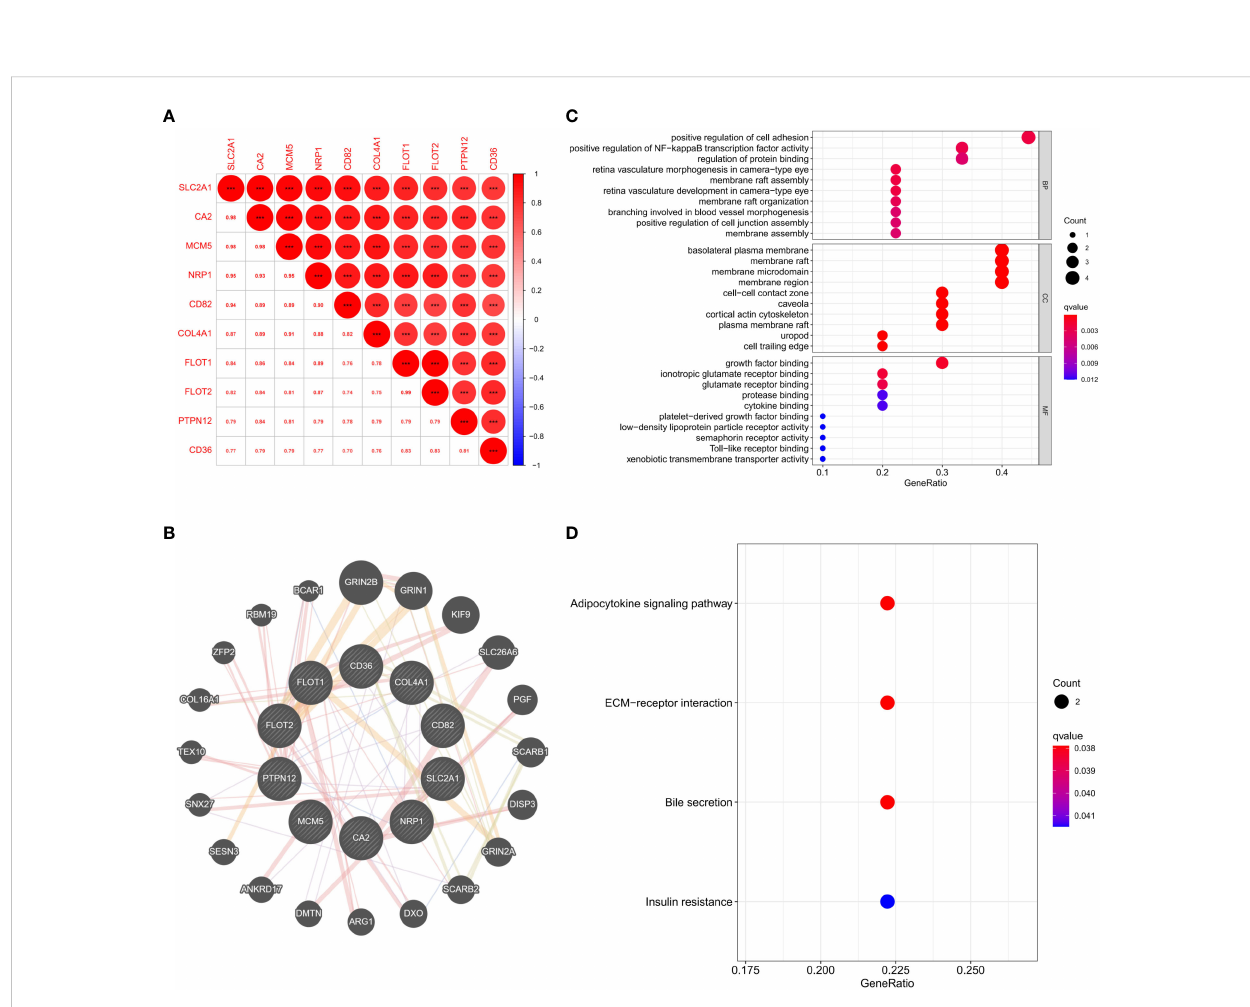
FIGURE 7 (A) Expression correlation analysis of SLC2A1 and its paired proteins in proteomics; (B) Protein interaction network of SLC2A1 and its paired proteins in the GeneMANIA database; (C) GO enrichment analysis of SLC2A1 and its paired proteins; (D) KEGG enrichment analysis of SLC2A1 and its paired